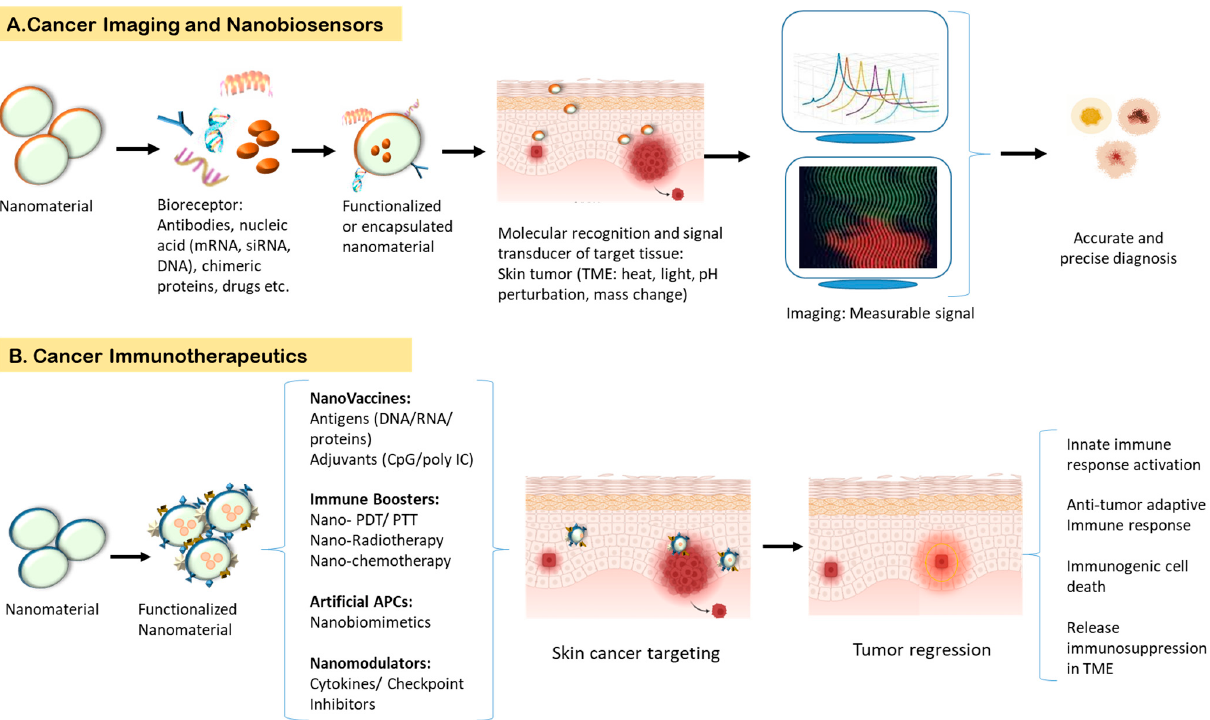
Figure 2. Mechanism of cancer diagnostics and therapeutics using nanosystems. ( A ) Nanomolecules can be functionalized with specific modulators (such as antibodies, nucleic acids, proteins, etc.) and targeted to specific cancer sites. Based on their ability to sense perturbations in pH, temperature and concentration changes, etc., signals can be generated and measured to precisely and accurately diagnose the type and stage of cancers ( B ) Nanosystems can be targeted to cancer microenvironment as a therapeutic modality to induce tumor regression.